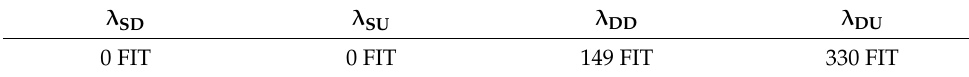
Table 6. Failure rates of the block valve included in the final element.